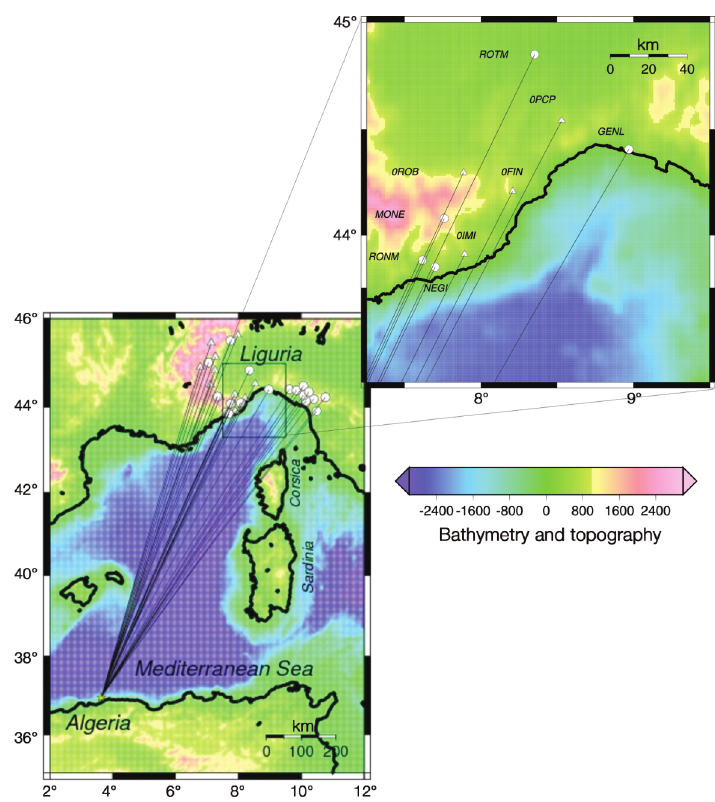
Fig. 1. Path connecting the epicenter (star) of the Algerian earthquake to RSNI recording stations in the Mediterranean Sea. Circles indicate the three-component stations and triangles the mono-component ones. The panel on the right hand-side shows a zoom on the stations used in this